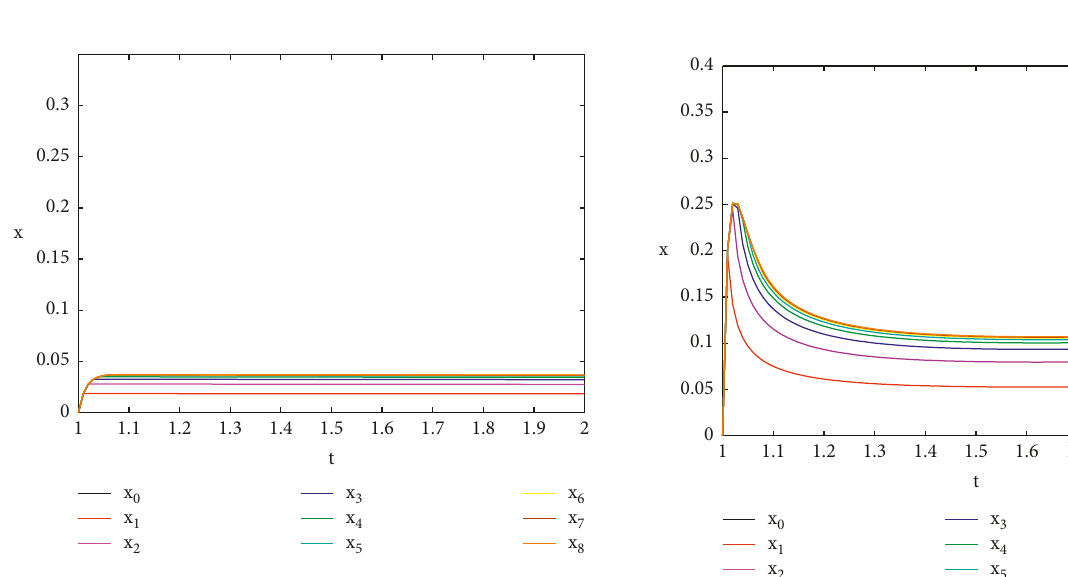
Figure 2: Case β � 0 and ρ � 0 . 5 with fractional derivative for α � 0 . 5. Figure 3: Case β � 0 and ρ ⟶ 0 + : the monotone iterative se-